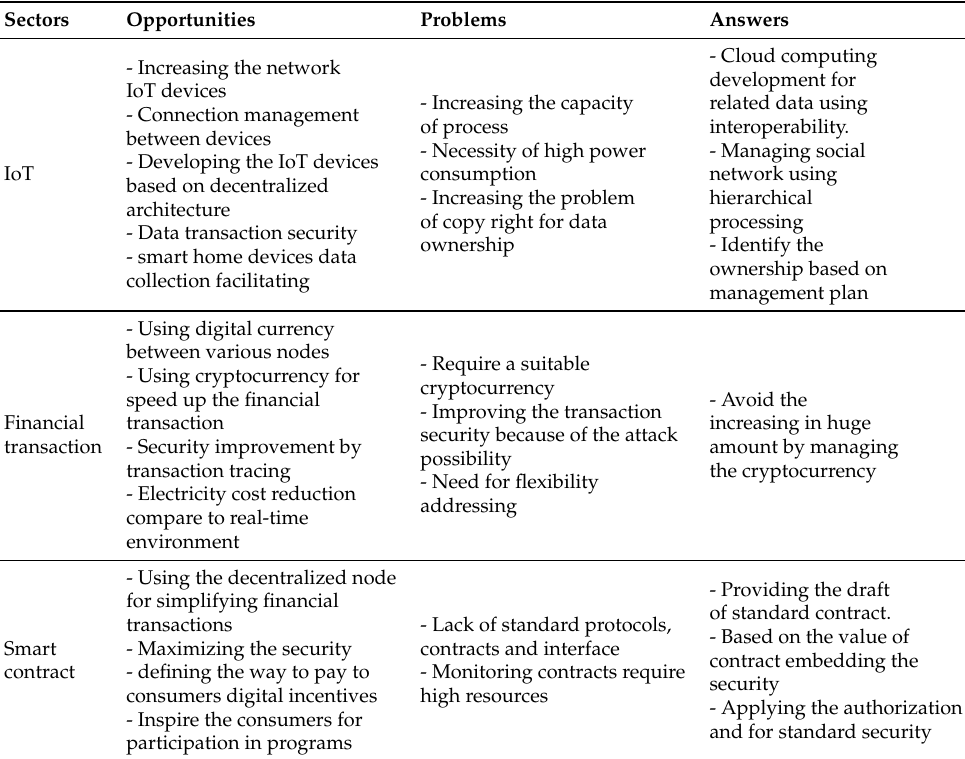
Table 2. Blockchain technology applications’ opportunities, problems, and